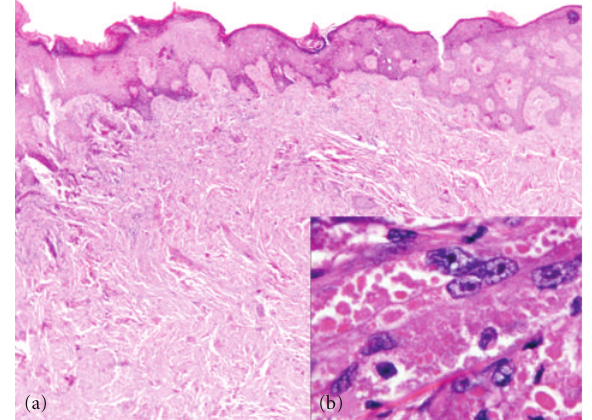
Figure 2: Ill-defined di ff use dermal infiltrate with overlying epidermal acanthosis (a). The tumor cells are large with granular cytoplasm (b) (H&E × 100 and ×